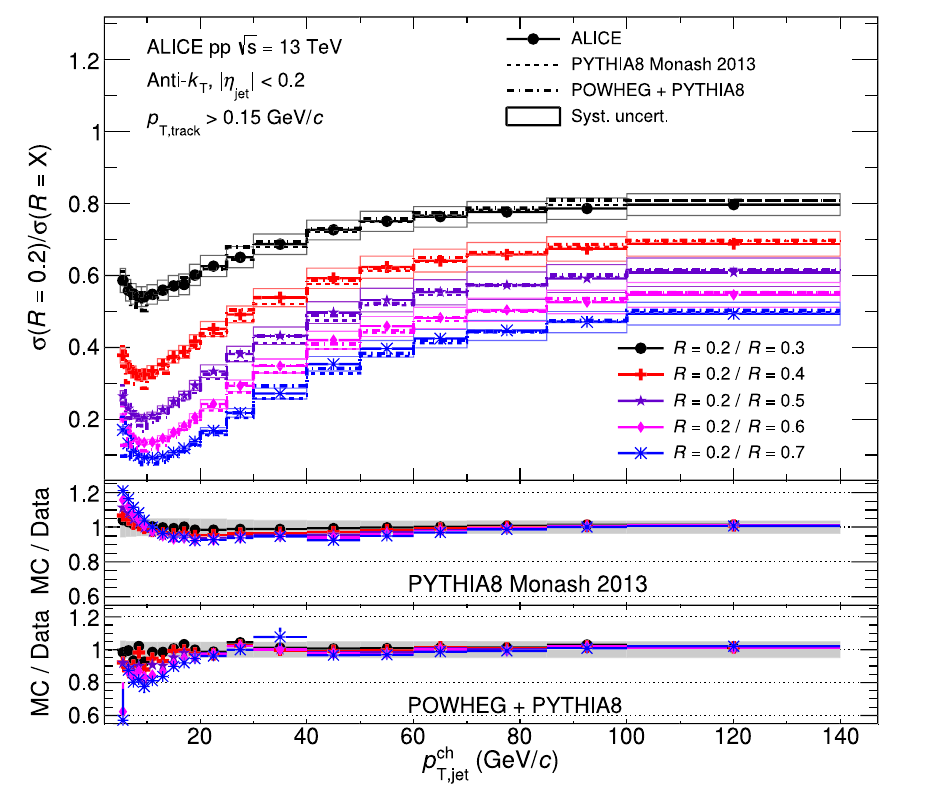
Fig. 17 Ratio of charged-particle jet cross section for resolution parameter R = 0 . 2 to other radii R = X , with X ranging from 0 . 3 to 0 . 7, without UE subtraction, and the comparison of calculations from LO(PYTHIA)andNLOeventgenerators(POWHEG+PYTHIA8). The